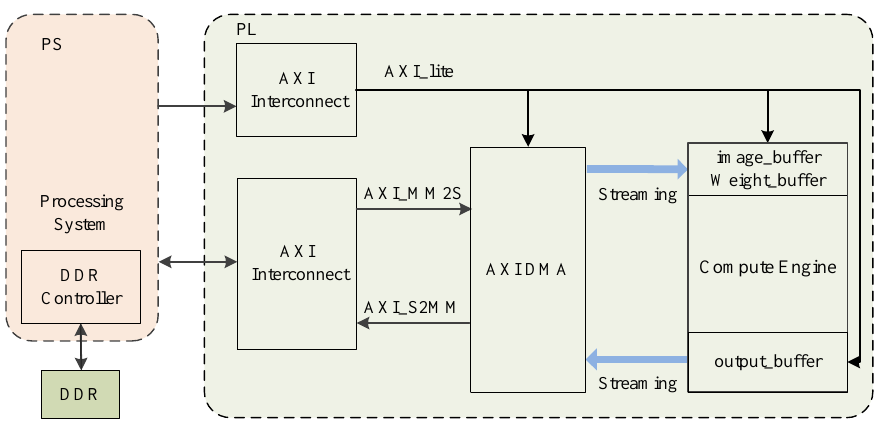
Figure 3. FPGA (field programmable gate array) architecture of system implementation.